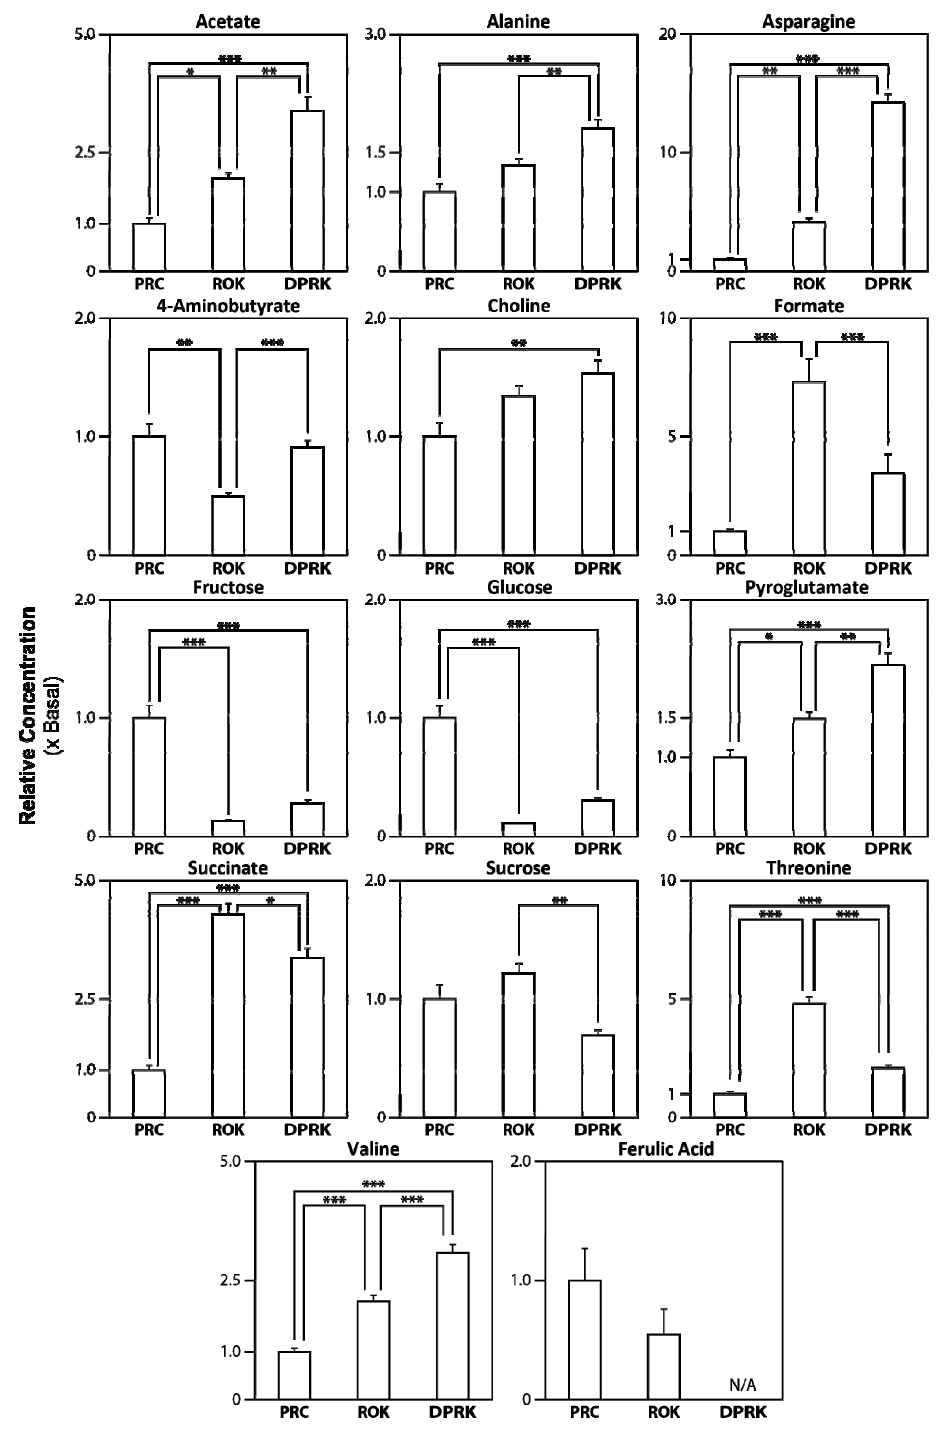
Figure 3. Quantification of identified metabolites in the different Angelica extracts. The peaks associated with identified metabolites (listed in Table 1 with respective chemical shifts) in all of the 1 H-NMR spectra were integrated to yield the concentrations in the extracts relative to the mean value for A. sinensis (PRC) (basal level set at 1.0). The values are expressed as Means ± SEM ( n = 5). * p ≤ 0.05, ** p ≤ 0.01, *** p ≤ 0.001, by one-way ANOVA followed by post-hoc multiple comparison tests. Abbreviations: PRC, A.